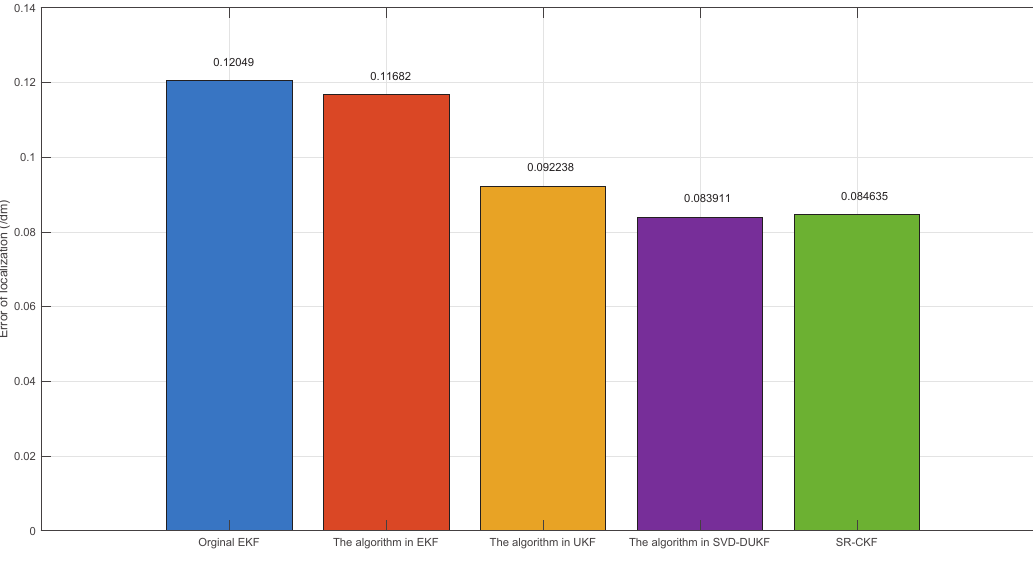
Figure 11. The mean of the localization